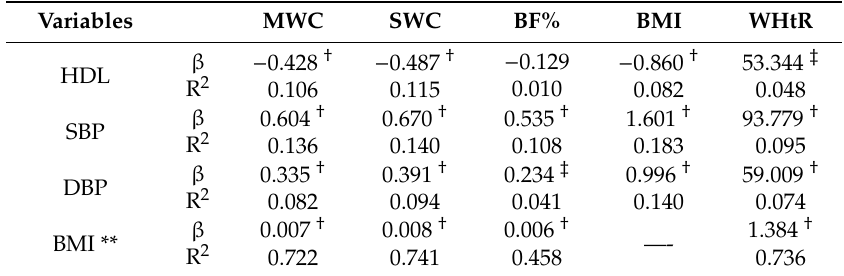
Table 3. Association between anthropometric indicators of obesity and metabolic variables in male adolescents (n =